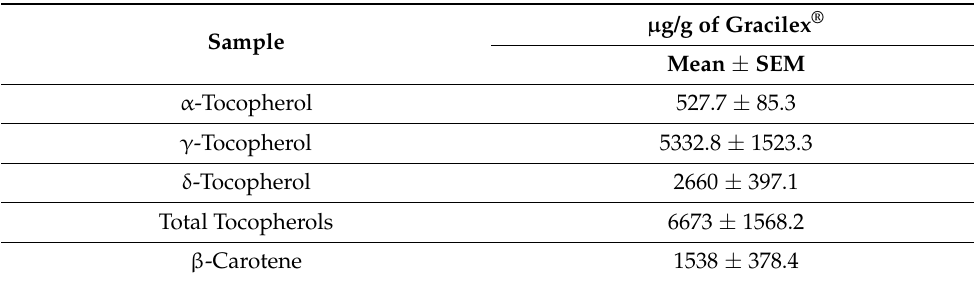
Table 3. Characterization of tocopherol and β -carotene content of Gracilex ® . Results are expressed as mean of six independent extract preparations ±